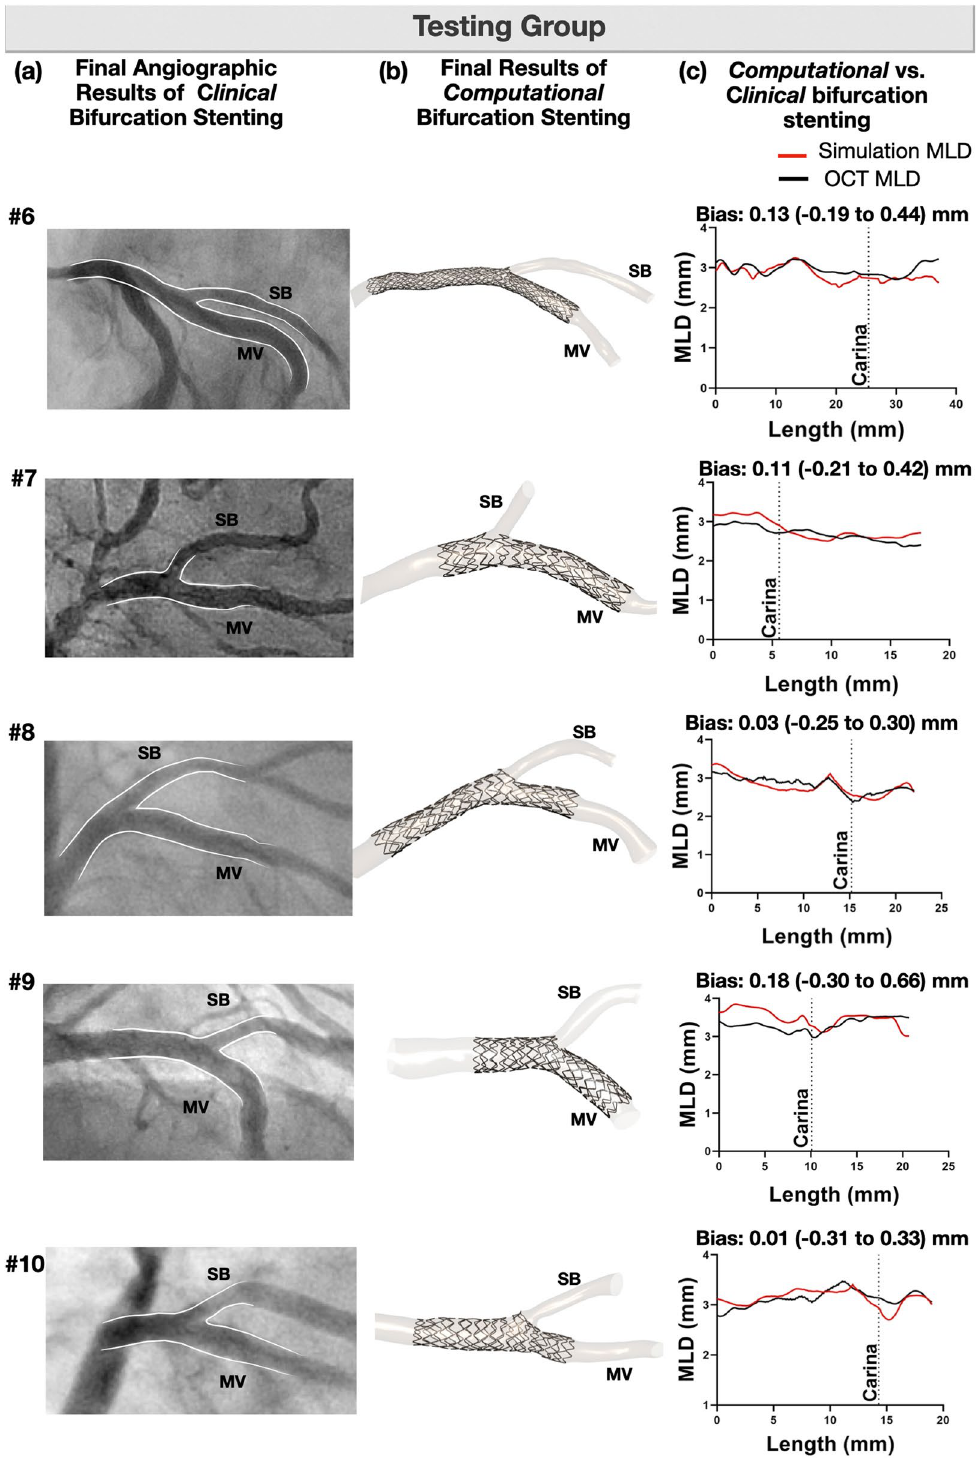
Figure 6. Blind comparison of computational stenting simulation versus angiography and OCT (Testing group). Qualitative ( a , b ), and quantitative ( c ) comparison of lumen size after computational stenting against angiography and OCT imaging. The graphs include the stented part of the lumen. Note that the computational stent simulation was blind to the final OCT results post-procedure; MV main vessel, SB side branch, MLD mean lumen